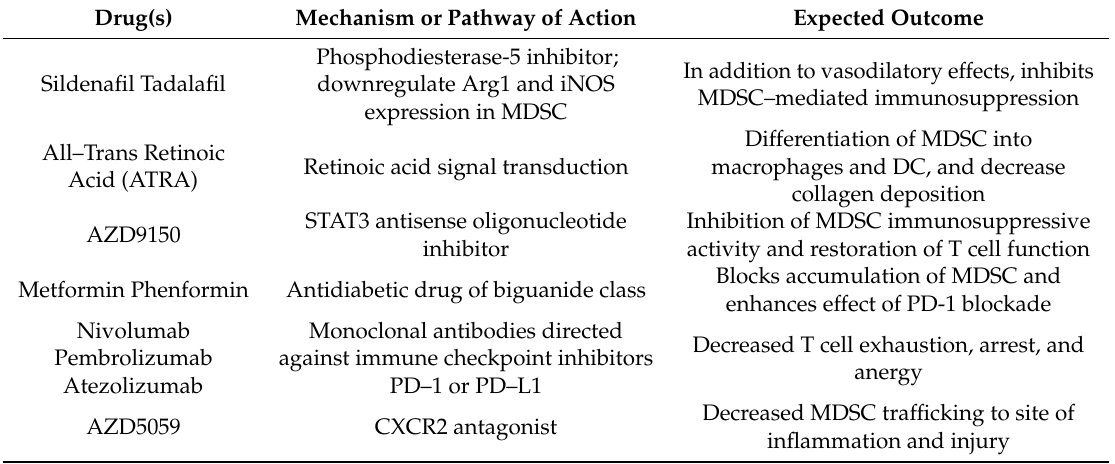
Table 2. Potential therapies targeting myeloid-derived suppressor cell (MDSC) in treatment of pulmonary hypertension (PH). Drug(s) Mechanism or Pathway of Action Expected